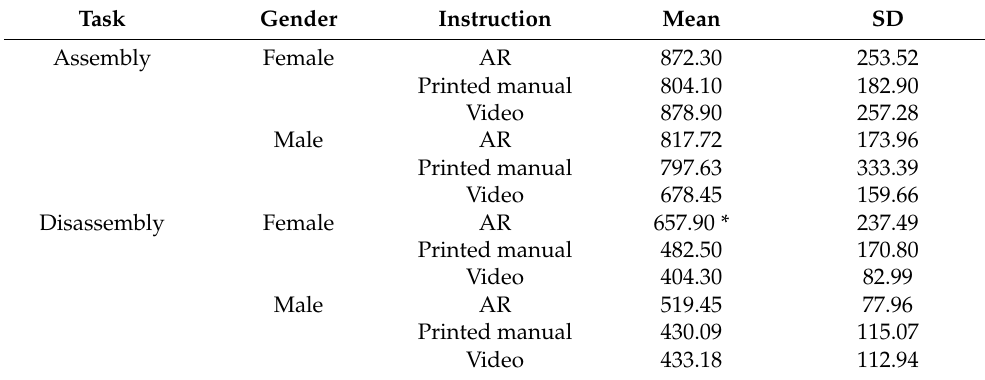
Table 3. Means and standard deviations (SD) of the time(s) to complete the task.